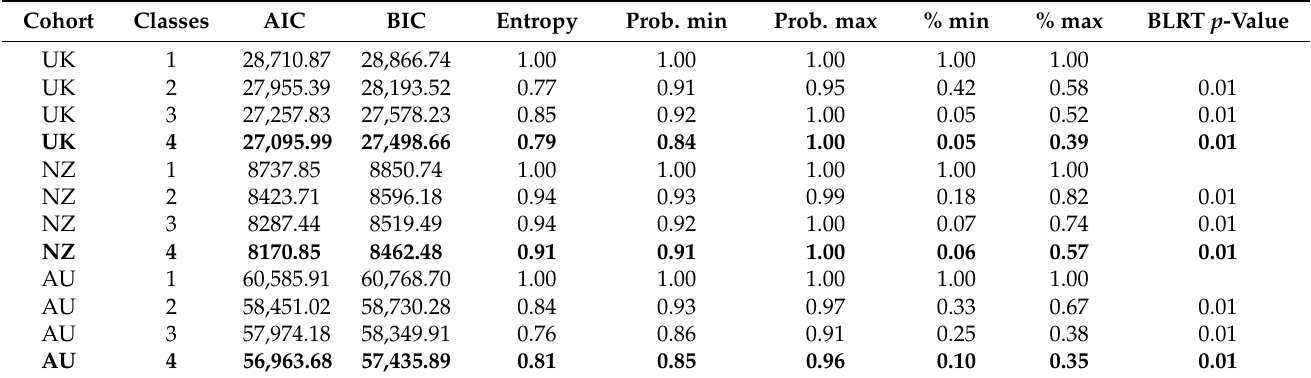
Table 2. Model fit indices of latent profile analyses for all models compared in UK